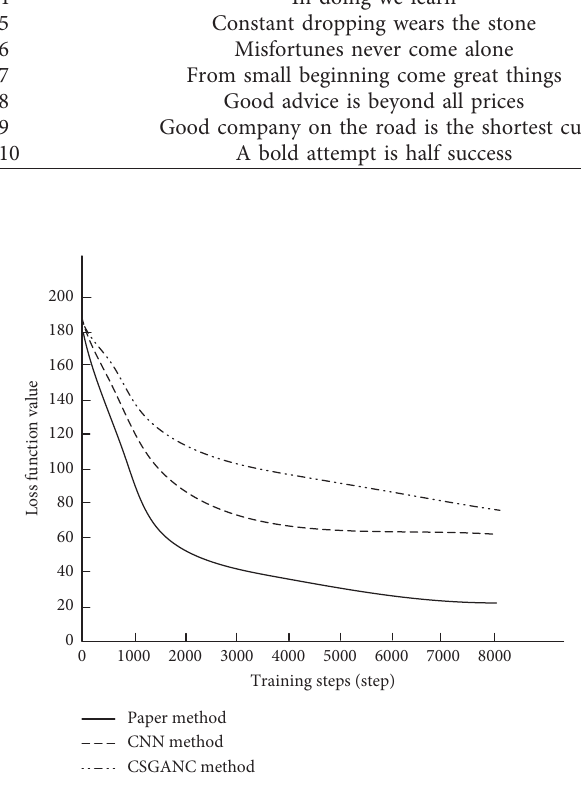
Figure 1: Loss function values of different